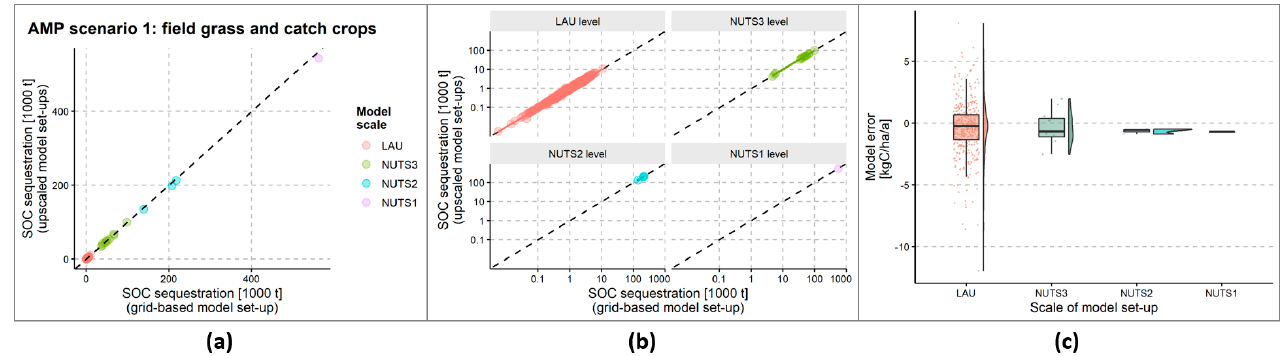
Figure 6. Carbon sequestration potential of the first alternative management practice (AMP-1; increasing soil carbon influx based on increased cultivation of field grass and cover crops) simulated with five different model set-ups. ( a ) Results of the grid-based reference simulation compared to the four upscaled model set-ups. ( b ) Same content as ( a ), but using a logarithmic scale for better visualization of carbon sequestration in smaller LAU regions. ( c ) Model errors in the assessment of AMP-1 for individual administrative